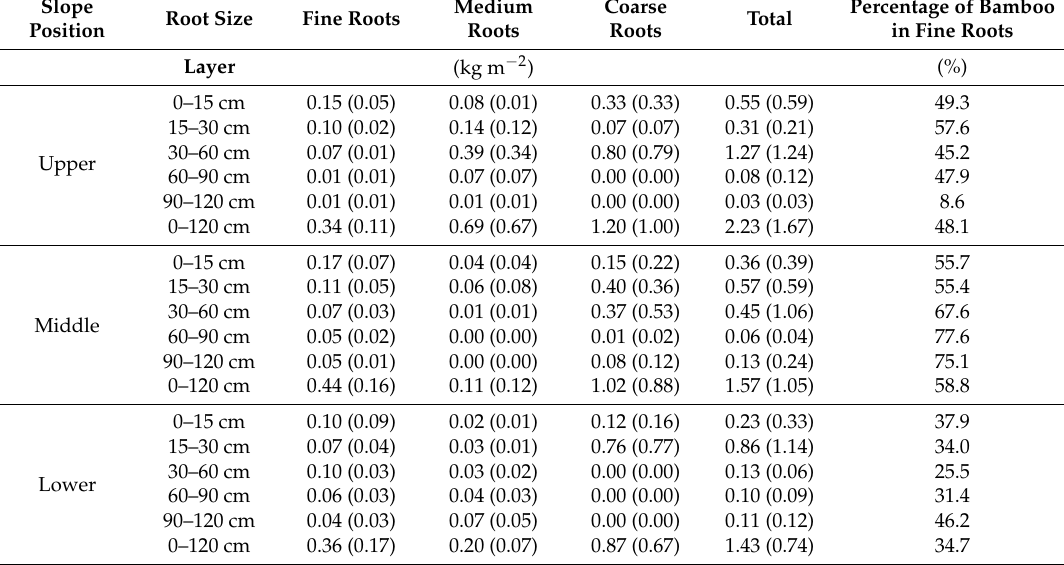
Table 3. Mean root biomass of fine (<3 mm in diameter), medium (3–10 mm), and coarse (>10 mm) roots and percentage of bamboo root biomass in the fine root biomass of the soil layers at different slope positions. Standard deviations are indicated within